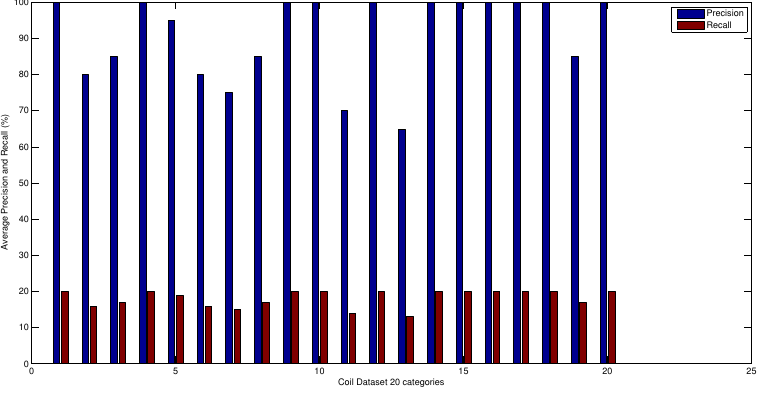
Figure 6. Average precision and recall results of the proposed method over 20 categories of COIL